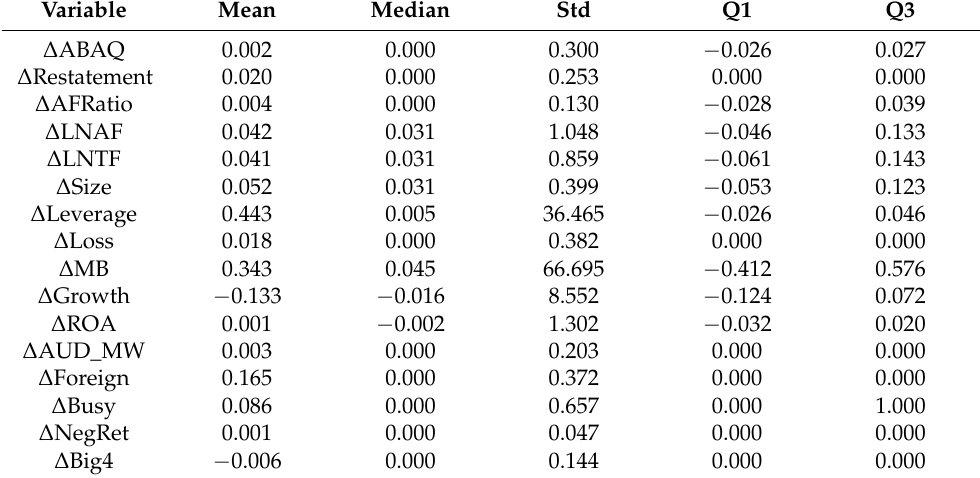
Table 2. Cont. Panel G: Descriptive Statistics for the ABAQ, Restatement, and AF of U.S. sample firms in 3-year pre-Rule 3211 period, after 1st-differencing.